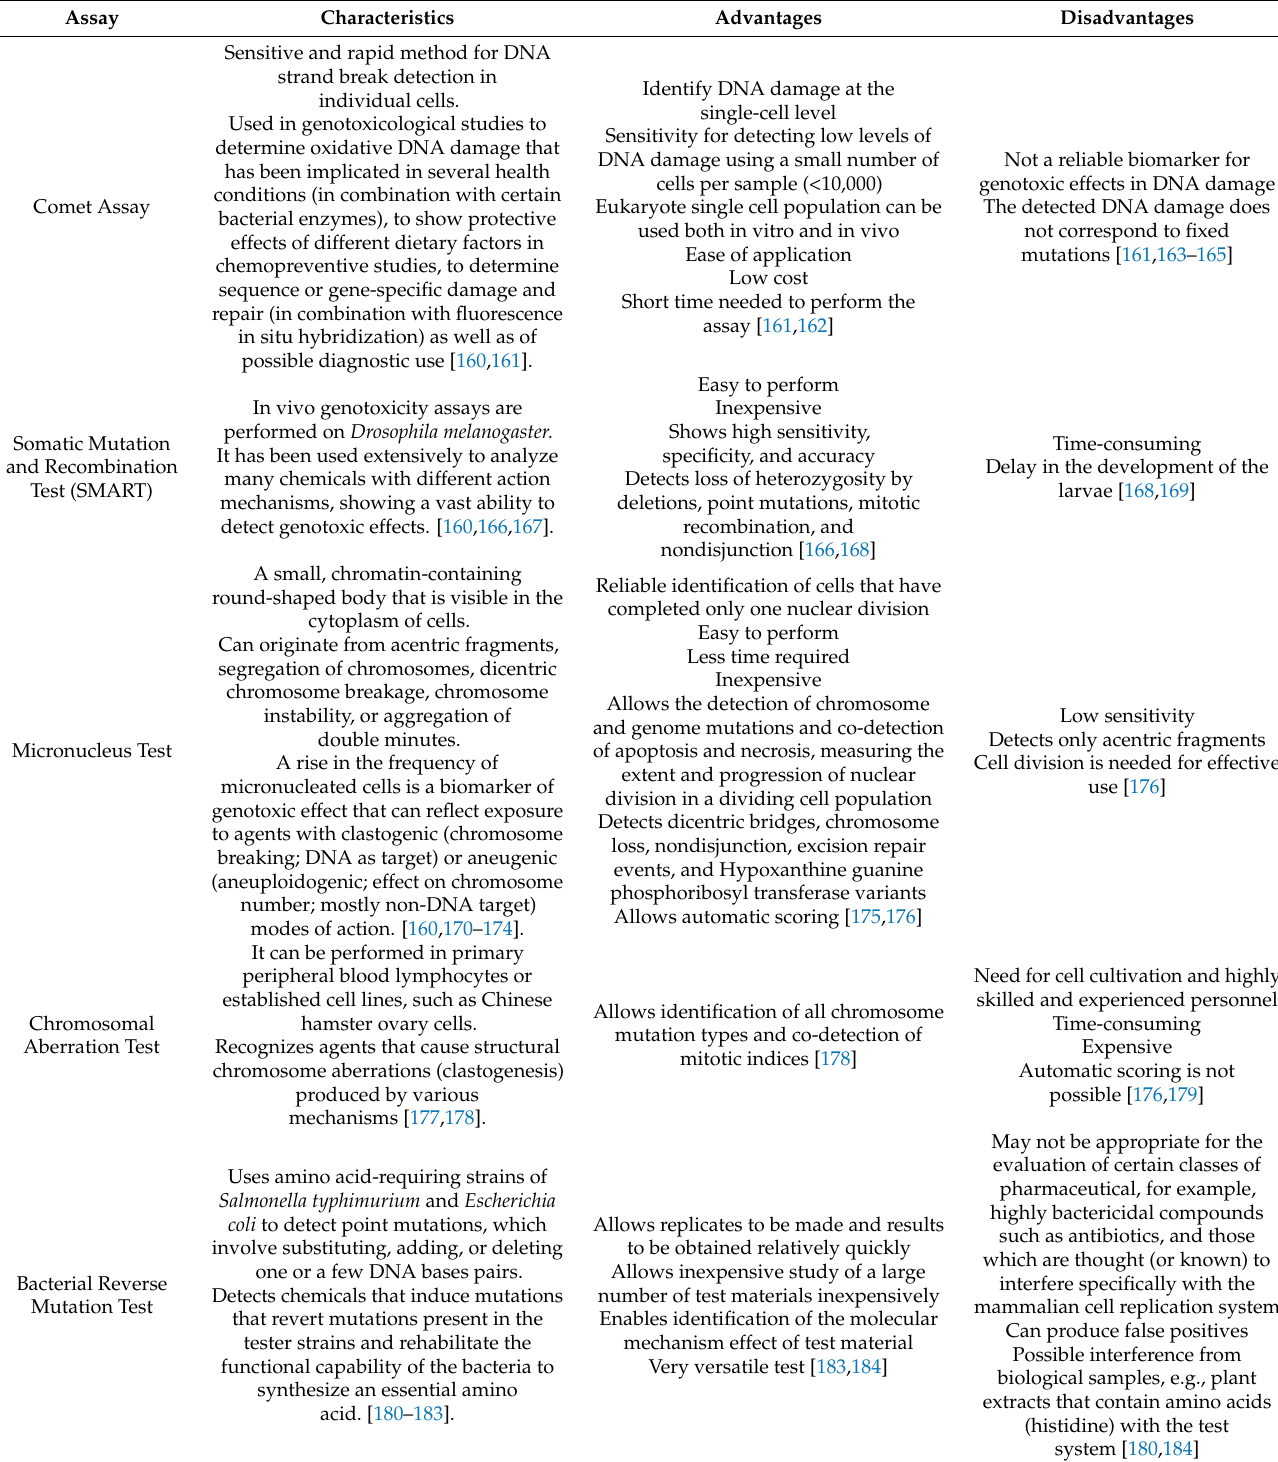
Table 6. Assays used in genotoxicological